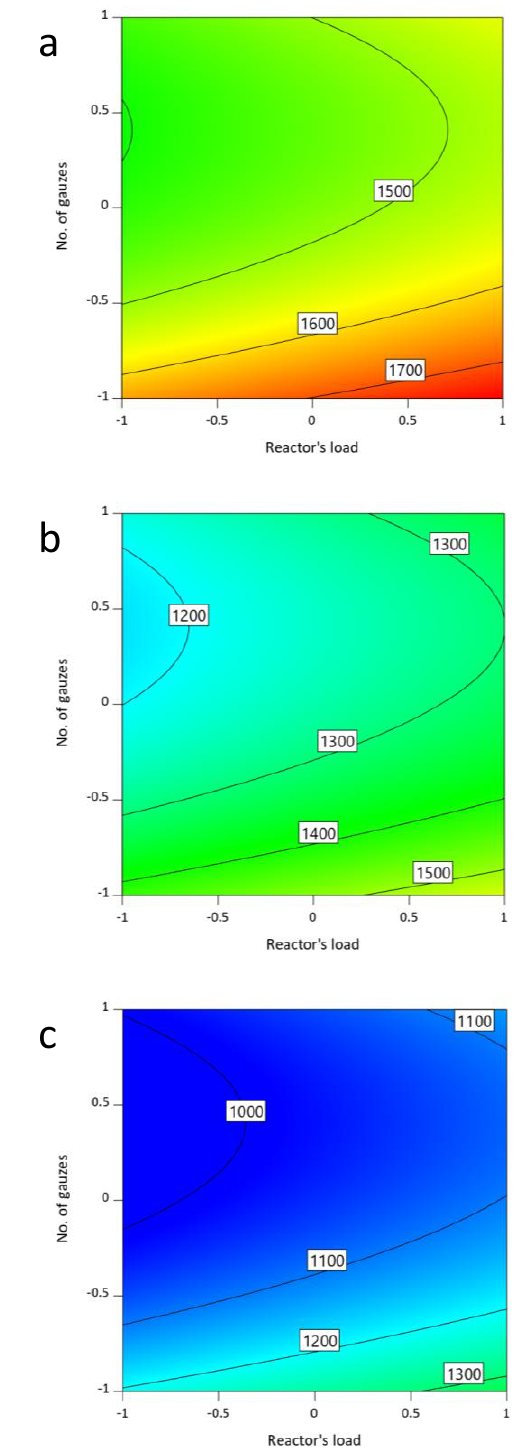
Figure 6. Interaction effect between the reactor’s load ( X 1 ) and the number of catalytic gauzes ( X 3 ) at fixed temperature (X 2 ) on N 2 O concentration in nitrous gases ( R 2 ) by contour plot. ( a ) X 2 = −1 ; ( b ) X 2 = 0; ( c ) X 2 = 1.